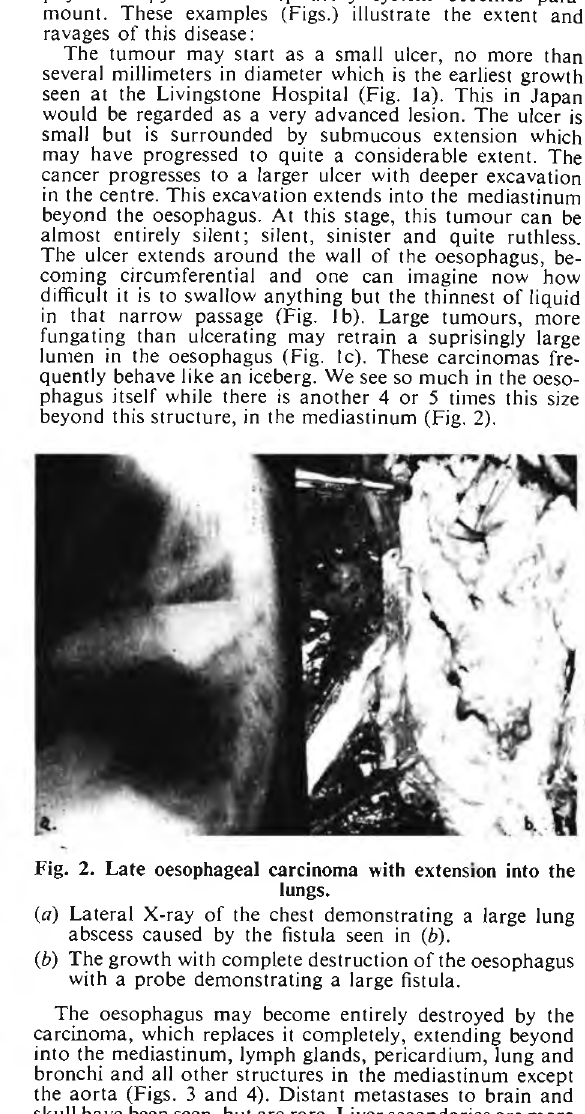
Fig. 1. Two operative specimens. (a) A malignant ulcer of the oesophagus measuring 7 mm. in diameter. This is one of the smallest and earliest